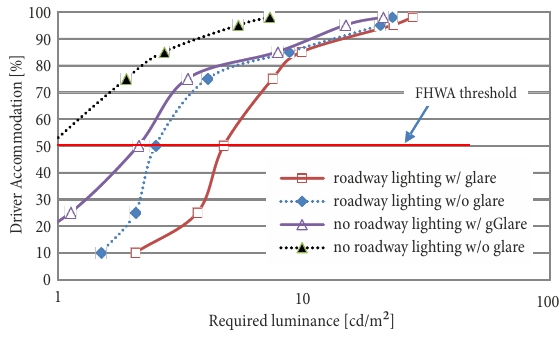
Fig. 1. Legend luminance required for guide signs ( legibility index = 30 ft/inch or 3.6 m/cm)